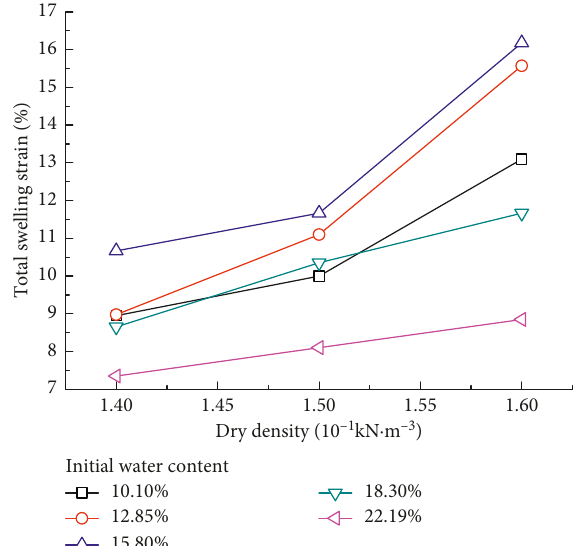
Figure 9: Relation of expansive deformation and dry density without a vertical load.